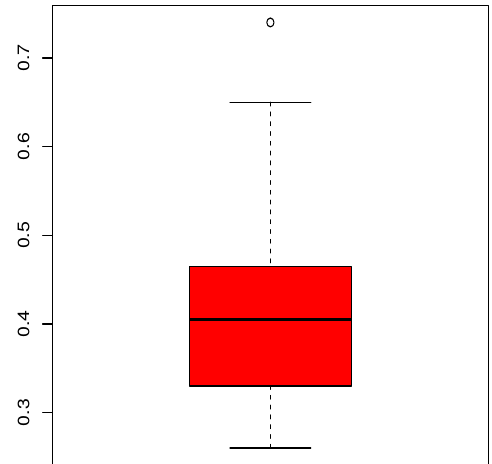
Figure 7. Boxplot for the flood level data